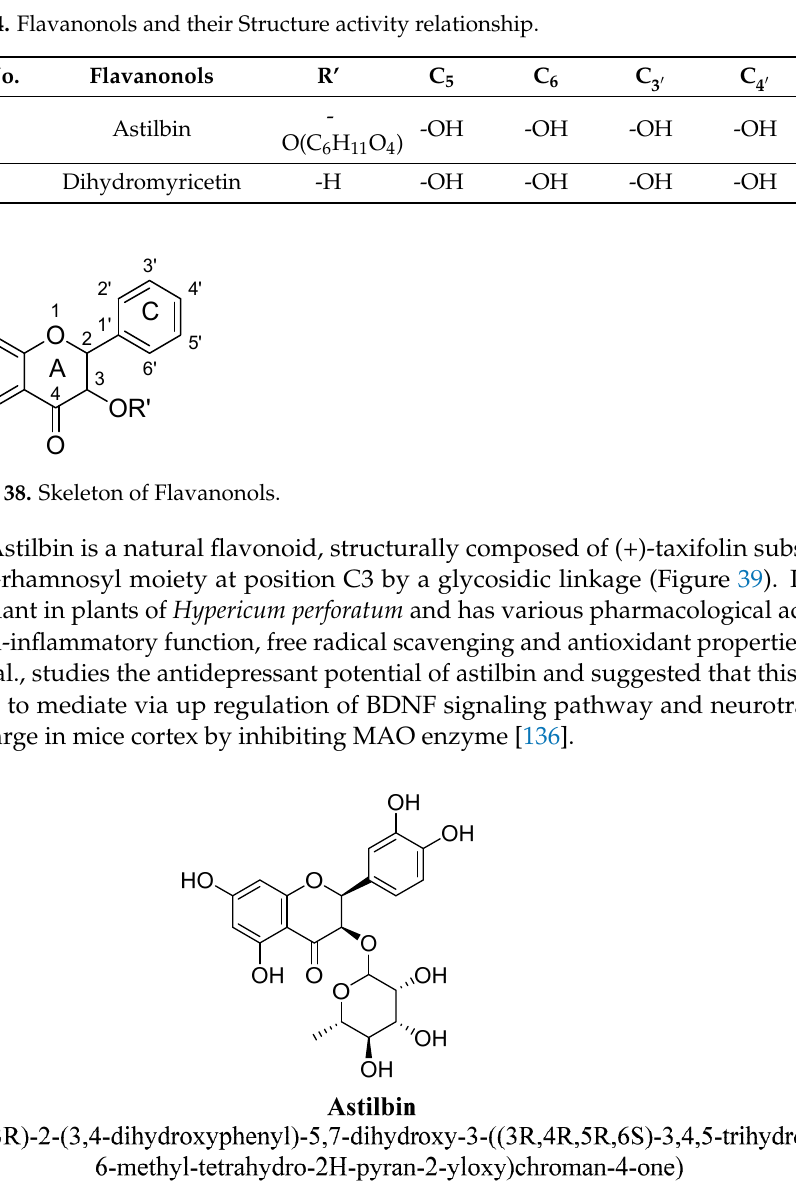
Figure 39. Astilbin. Figure 39.